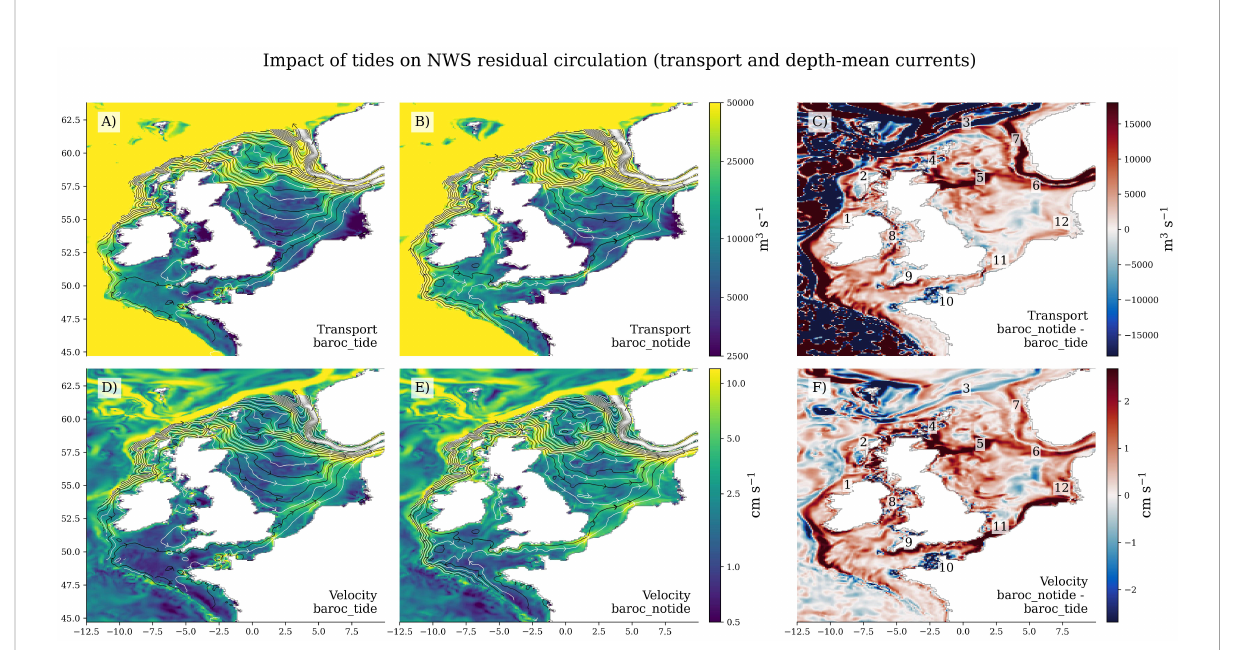
FIGURE 1 NWS Winter residual circulation in terms of volume transport (m 3 s -1 , A – C ) and depth-mean velocities (m s -1 D – F ) for baroc_tide (A, D) and baroc_notide (B, E) , and their differences (C, F) . baroc_tide and baroc_notide are the simulations with and without tides and are de fi ned in section 2.2. The colouring shows the magnitude (on a logarithmic scale) of the transport (A, B) and velocity (D, E) , while the streamlines (and arrows) show the direction. The streamlines are alternately coloured black and white for clarity. (C, F) shows the difference in magnitude of transport ( C , m s -1 ) and velocity ( F , cm s -1 ) between baroc_notide – baroc_tide, showing regions where baroc_notide is greater than baroc_tide in red. The numbers in (C, F) refer to pertinent circulation features, which are described in Box